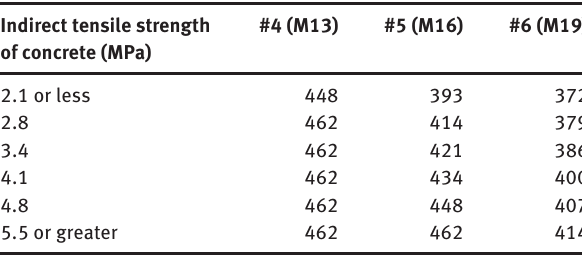
Table 2: Allowable working stress limits (MPa) for Grade 420 rein- forcement